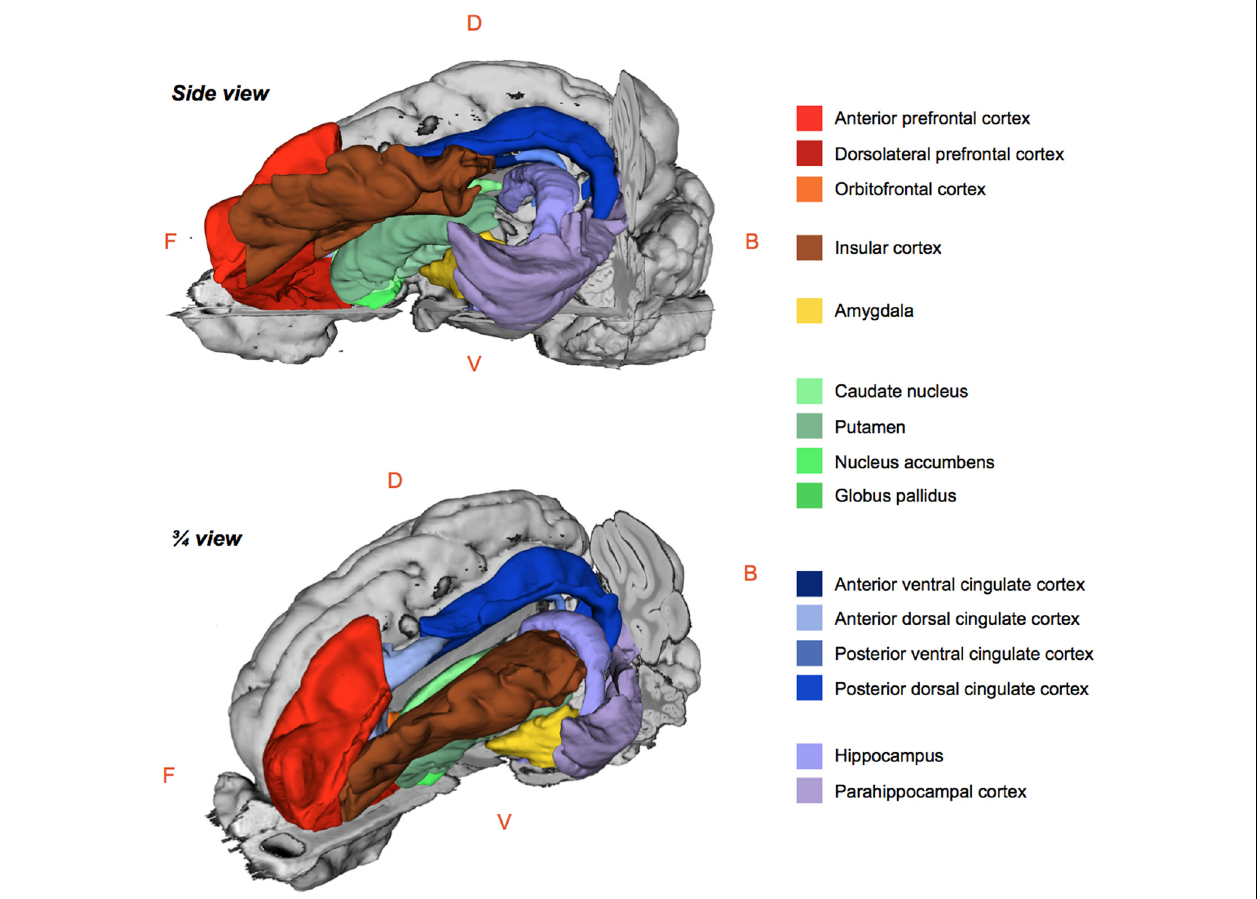
FIGURE 3 | Schematic 3D-representations of a pig’s brain showing the whole right hemisphere (gray) and a skinned left hemisphere with the regions of interest selected for the brain metabolism small volume correction (SVC) analysis using statistical parametric